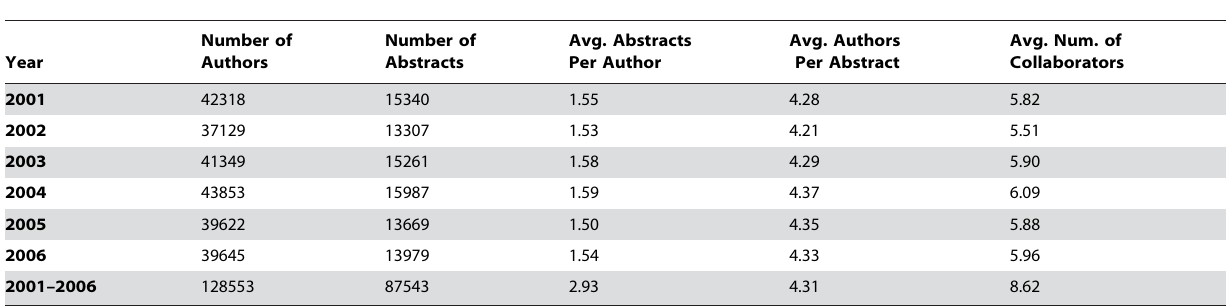
Table 3. Basic statistics of SFN data for the 6-year period between 2001 and 2006.